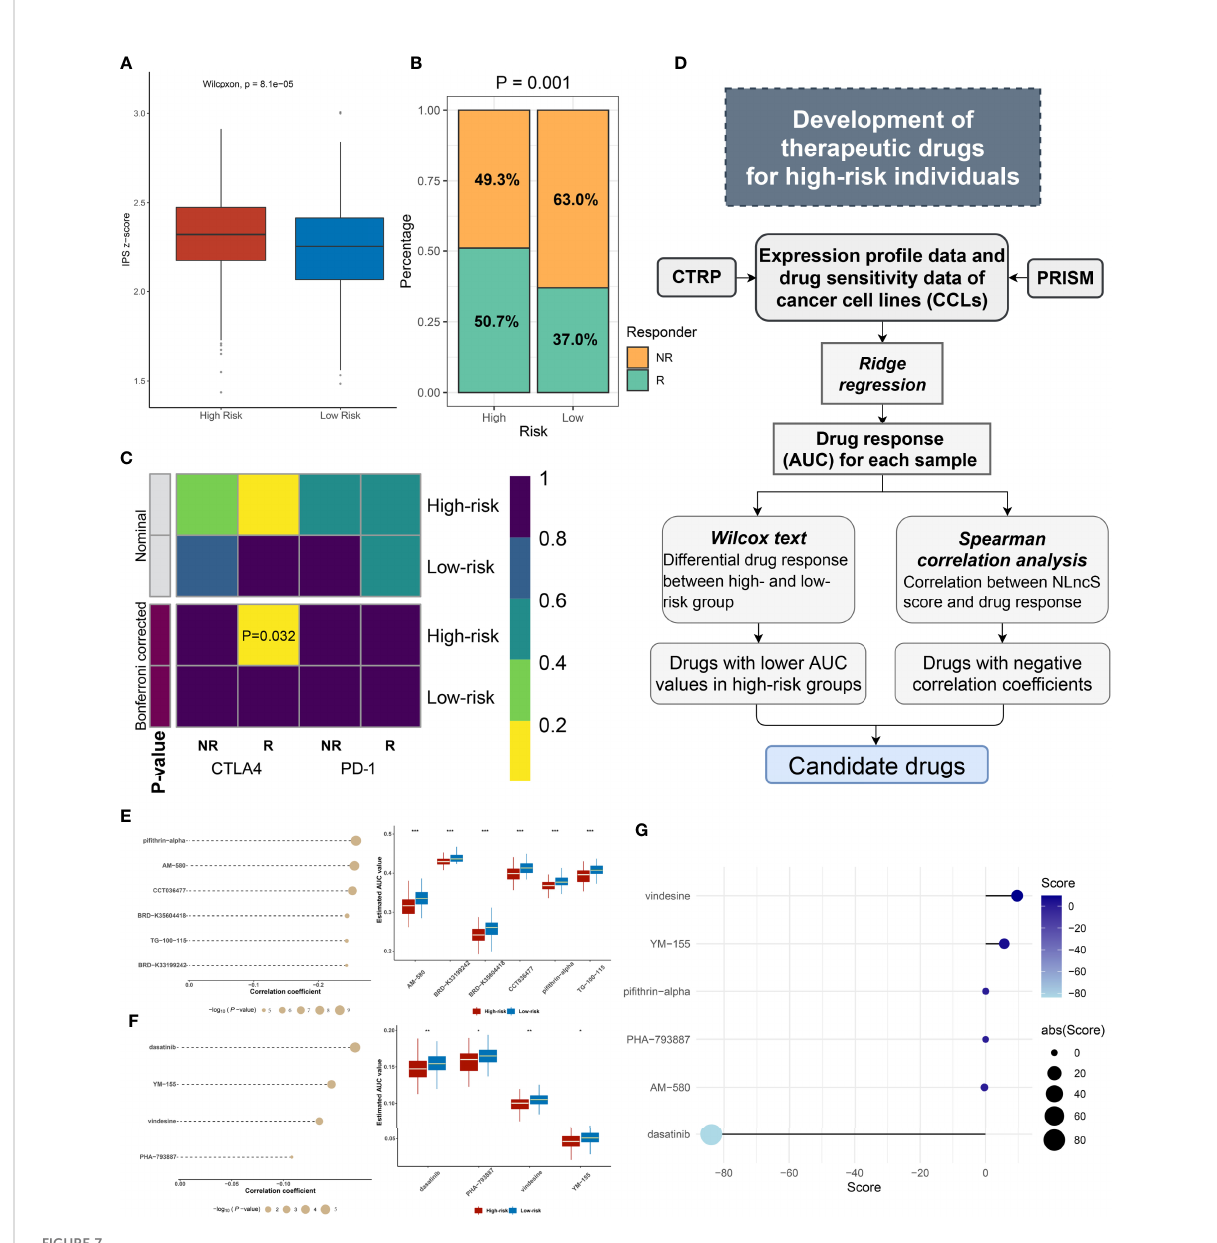
FIGURE 7 Ef fi cacy evaluation of immunotherapy and potential drug screen for CRC patients. (A) The IPS z-score of the two groups. (B) The predicted ef fi cacy of the two groups to immunotherapy in TCGA cohorts via TIDE method. (C) SubMap analysis of the two groups and 47 pretreated patients with comprehensive immunotherapy annotations in TCGA cohort. For SubMap analysis, a smaller P-value implied a higher similarity of paired expression pro fi les. (D) The framework of exploring insidious drugs for high-risk patients. (E, F) The candidate drugs screened by CTRP and PRISM datasets. The correlation analysis of drugs and high-risk groups in CTRP (E left ) and PRISM (F left ) . The differential drug response between high- and low-risk groups in CTRP (E right ) and PRISM (F right ) . (G) CMap analysis identi fi ed dasatinib as a potential compound able to target the high-risk patient. (*P< 0.05; **P< 0.01; ***P<